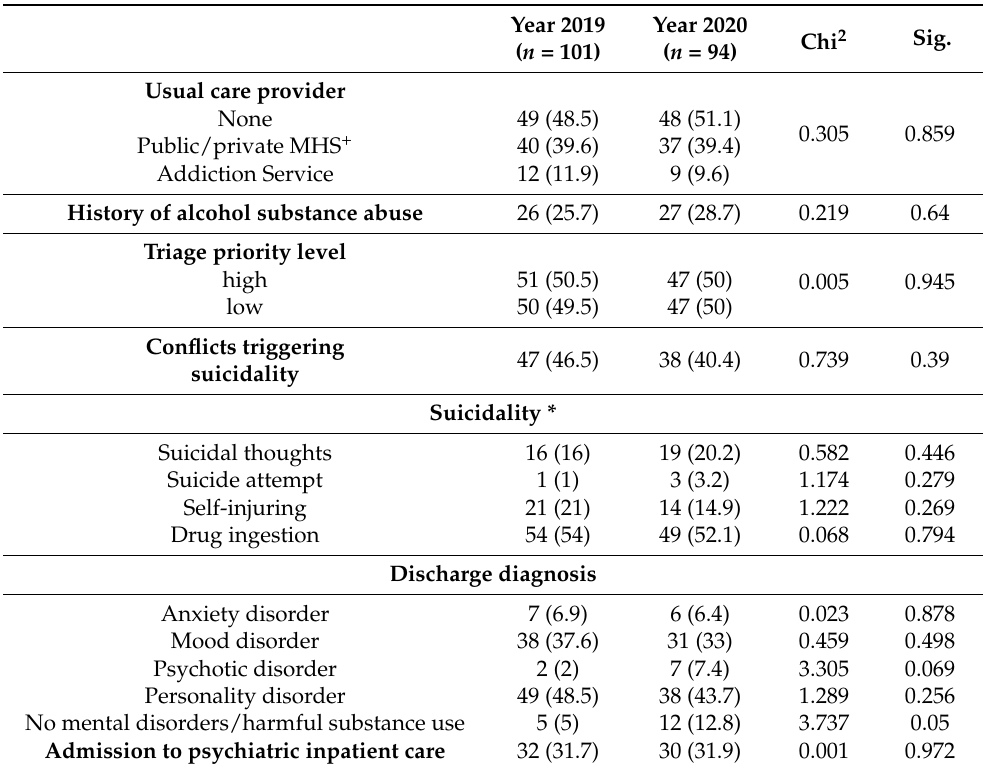
Table 2. Clinical characteristics of the study